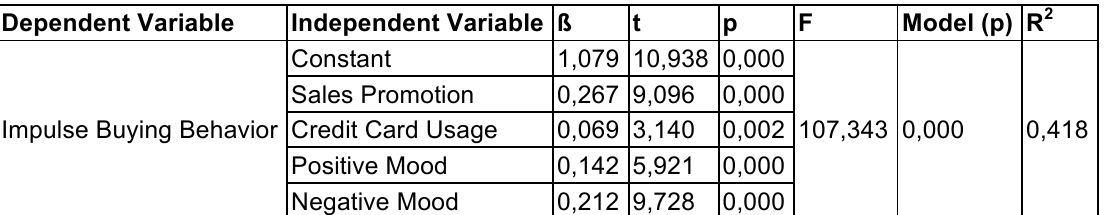
Table 4: Regression